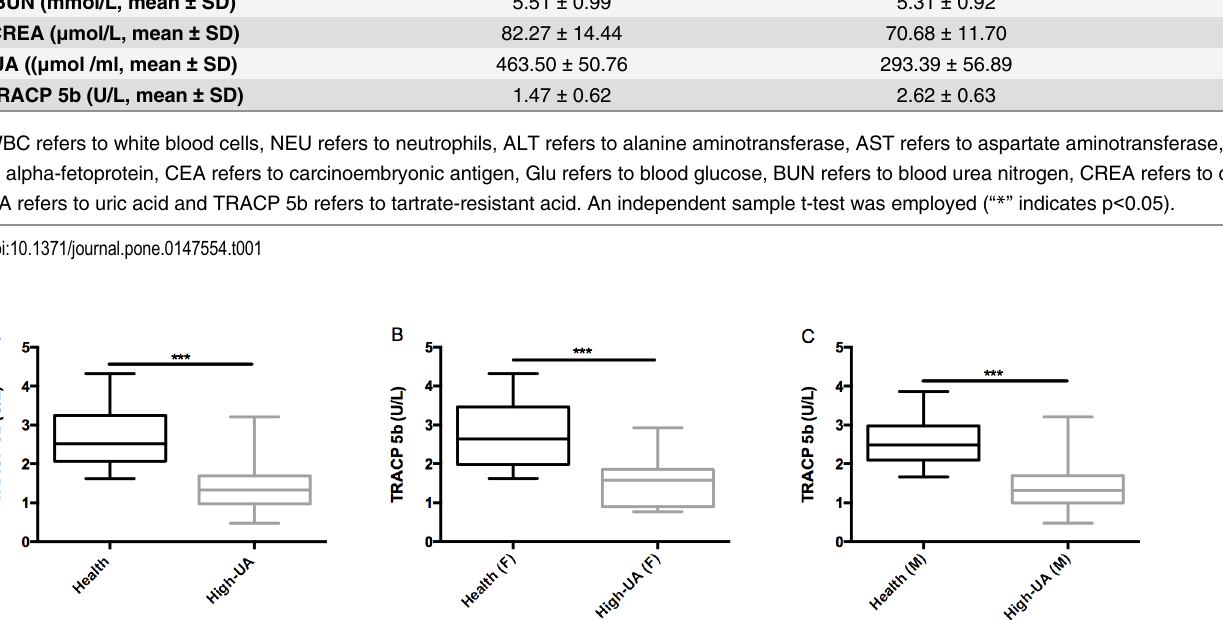
Fig 1. Negative correlation between the concentrations of UA and TRACP 5b. (A) The average TRACP 5b levels of the 77 high-UA individuals (1.47 ± 0.62 U/L) were significantly lower (t-test, p < 0.0001) than that of the 77 healthy subjects (2.62 ± 0.63U/L). (B) The average TRACP 5b levels of the 16 female high-UA individuals (1.51 ± 0.64 U/L) were significantly lower (t-test, p < 0.0001) than that of the 16 female healthy subjects (2.73 ± 0.86 U/L). (C) The average TRACP 5b levels of the 61 male high-UA individuals (1.46 ± 0.62 U/L) were significantly lower (t-test, p < 0.0001) than that of the 61 male healthy subjects (2.59 ± 0.56 U/L). Triple asterisk indicates p <